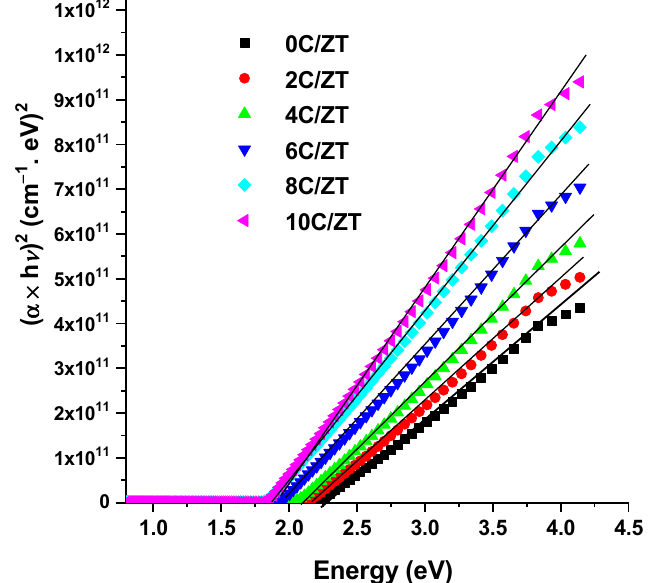
Figure 10. ( α h ν ) 2 versus h ν of the undoped and Cu-doped ZnTe films at different Cu contents.